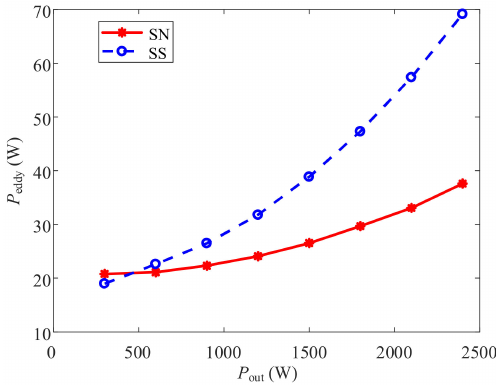
Figure 9. The ECL varying with the output